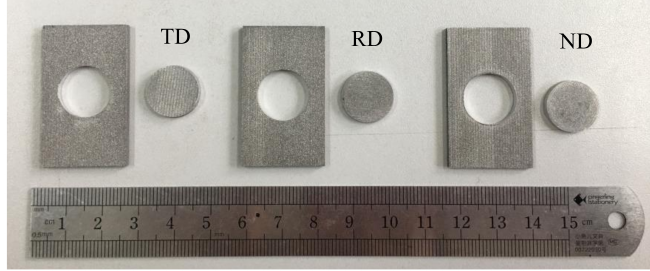
Figure 5. Crack photos of specimens of three forming